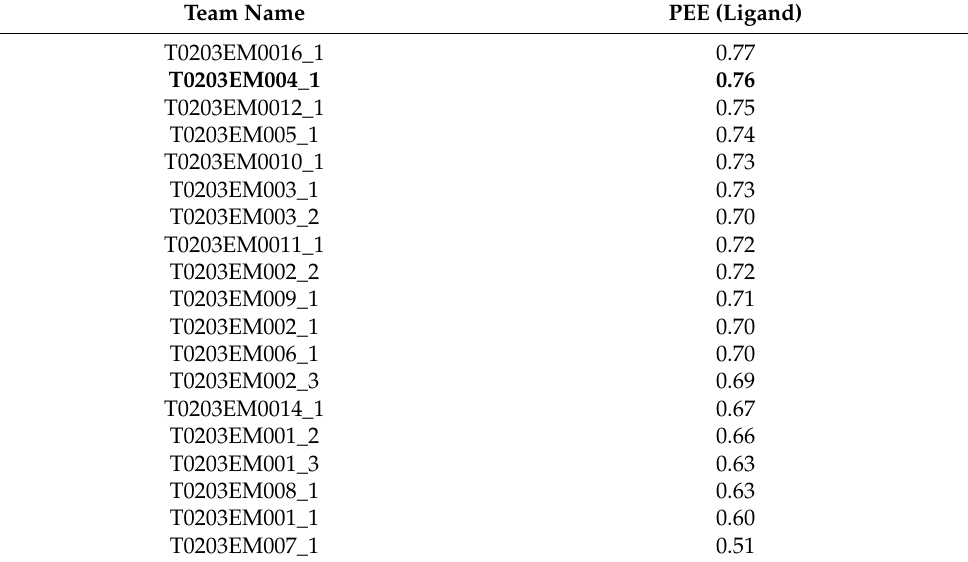
Figure 8. Target 203. ( A ) T0203EM0004_1 (ours) docked by Target 203 (EMD-22898) and visualized with electrostatic potential surface generated in UCSF Chimera. ( B ) Ligand PEE, image extracted from Protein Data Bank (PDB). ( C ) Protein–ligand interactions in T0203EM0004_1 (our) model. Chains are colored differently (chain A: blue, chain B: pink, chain C: green, and chain D: golden). The ligand are labeled with their atom names as well as the ligand’s name (PEE). Table 6. Evaluation of Target 203: SARS-CoV-2 ORF3a putative ion channel in nanodisc on Q-score for all the models submitted in the 2021 Ligand Model